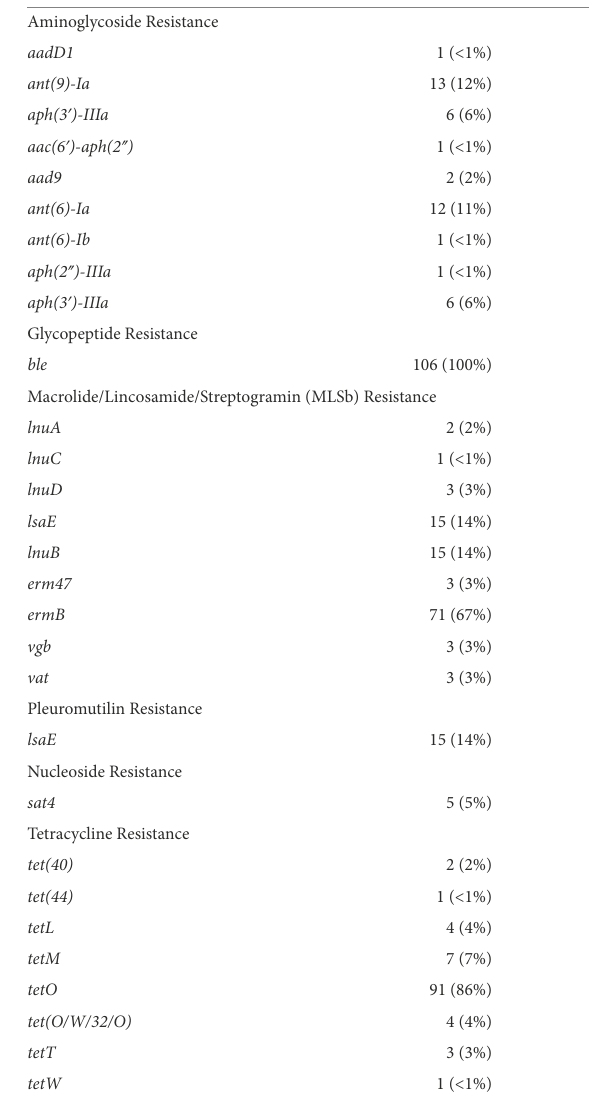
TABLE 2 Prevalence of serotypes among S. suis isolates.